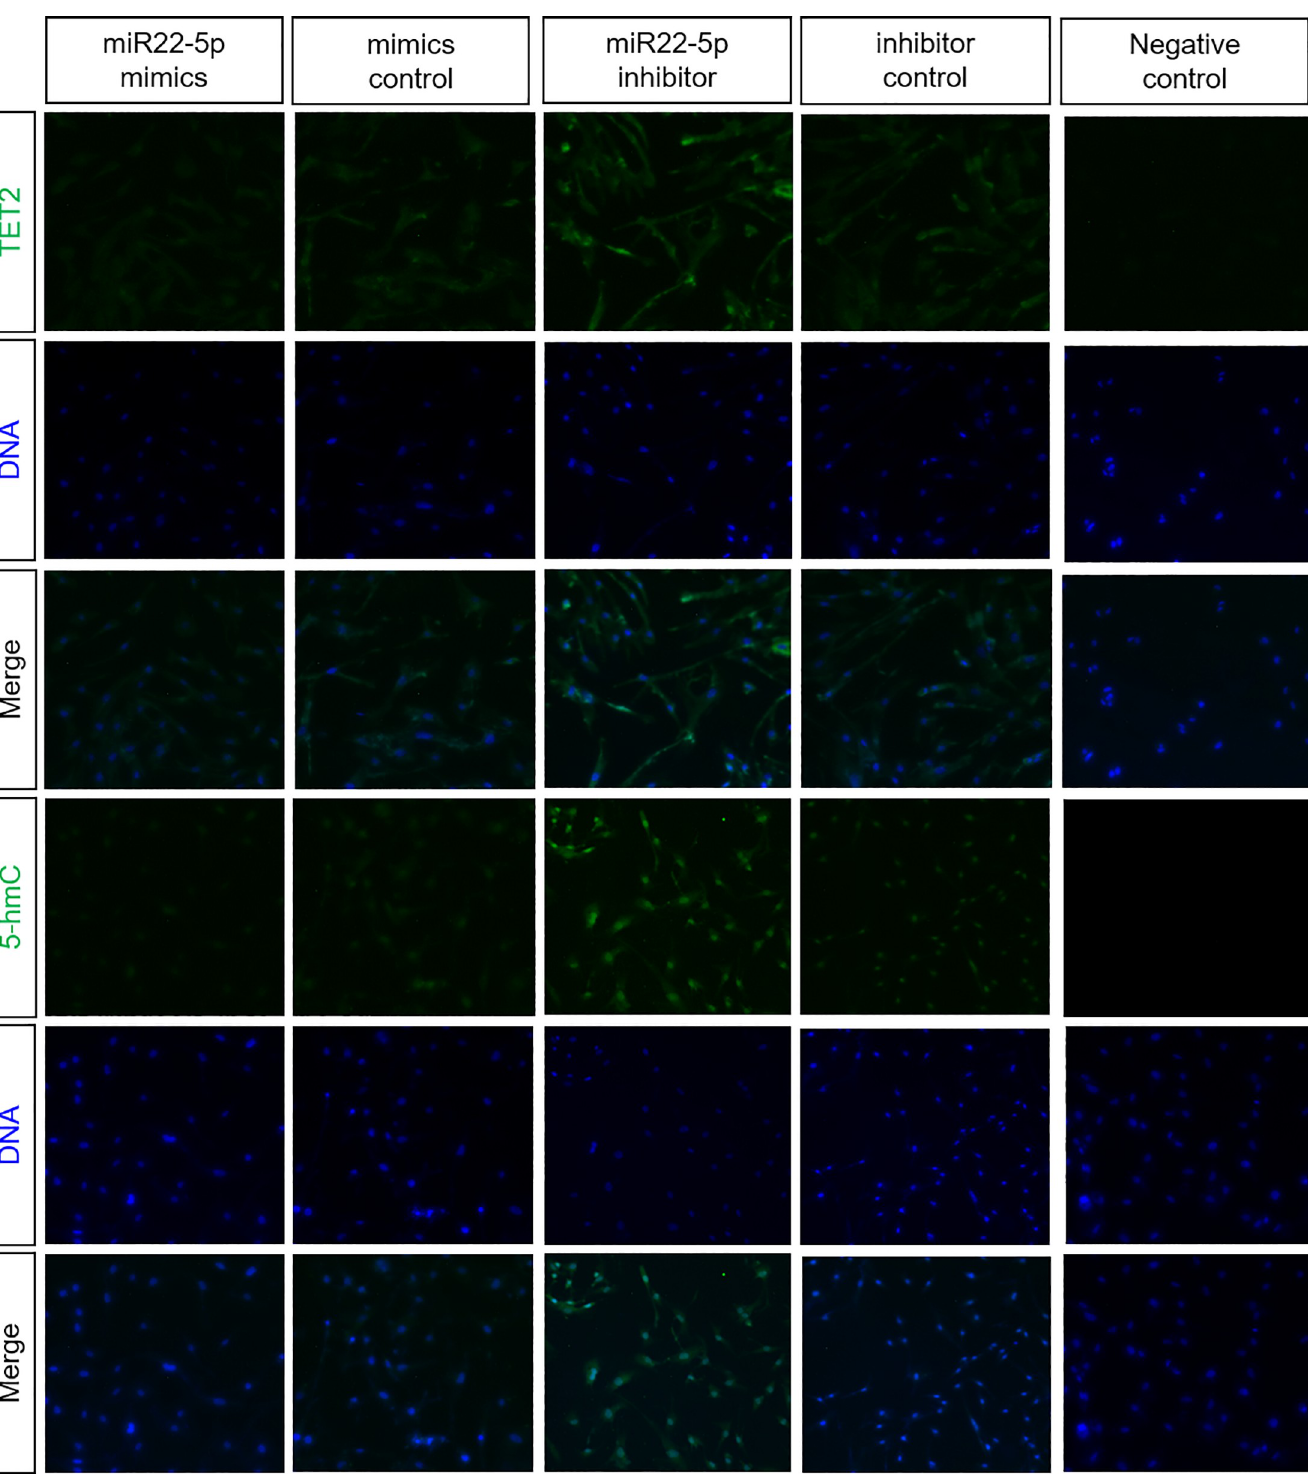
PLOS ONE | https://doi.org/10.1371/journal.pone.0234086 July 13,